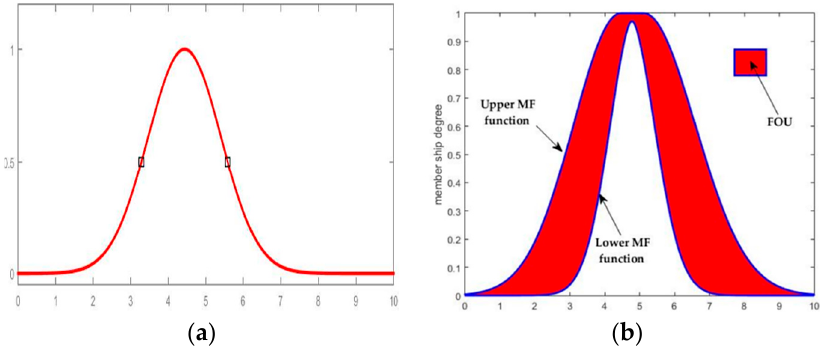
Figure 7. ( a ) Type-1 membership function. ( b ) Type-2 membership function.